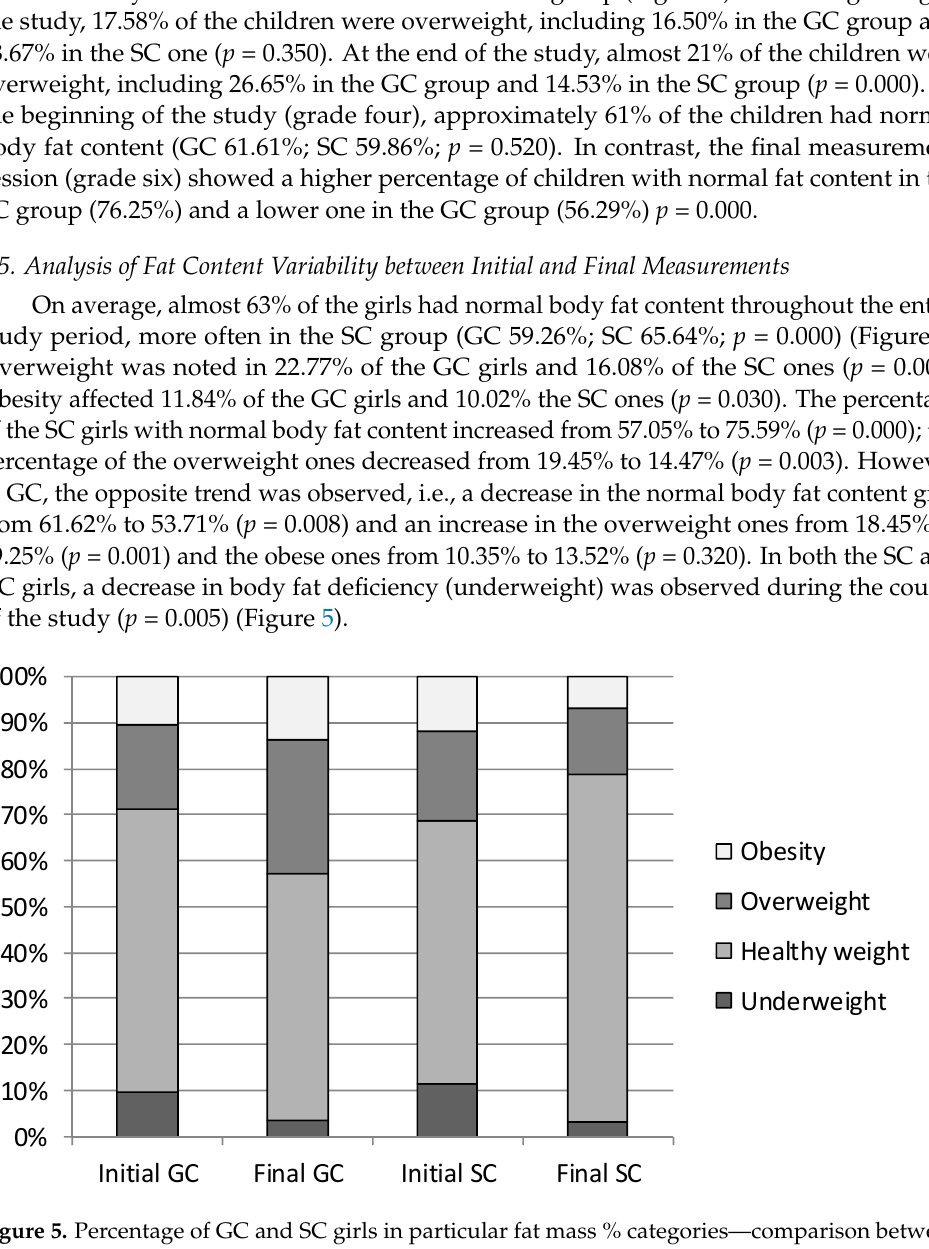
Figure 5. Percentage of GC and SC girls in particular fat mass % categories—comparison between initial (I) and final (F) measurement session. Initial—initial measurement session; Final—final measurement session; GC—general education classes (standard PA, 4 h a week); SC—sport classes (elevated PA, 10 h). I—Initial measurement; F—final measurement; GC—general education classes (standard PA, 4 h a week); SC—sport classes (elevated PA, 10 h a week).